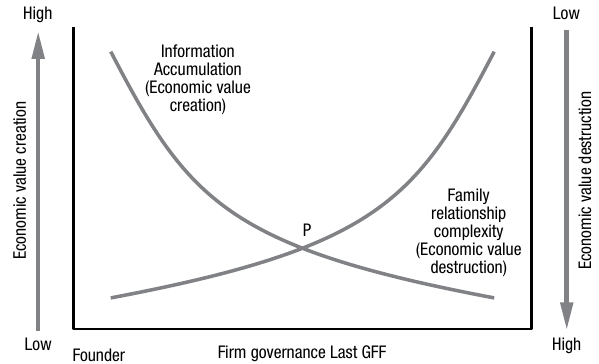
Fig. 1 . Family firm governance (GFF), economic value creation and